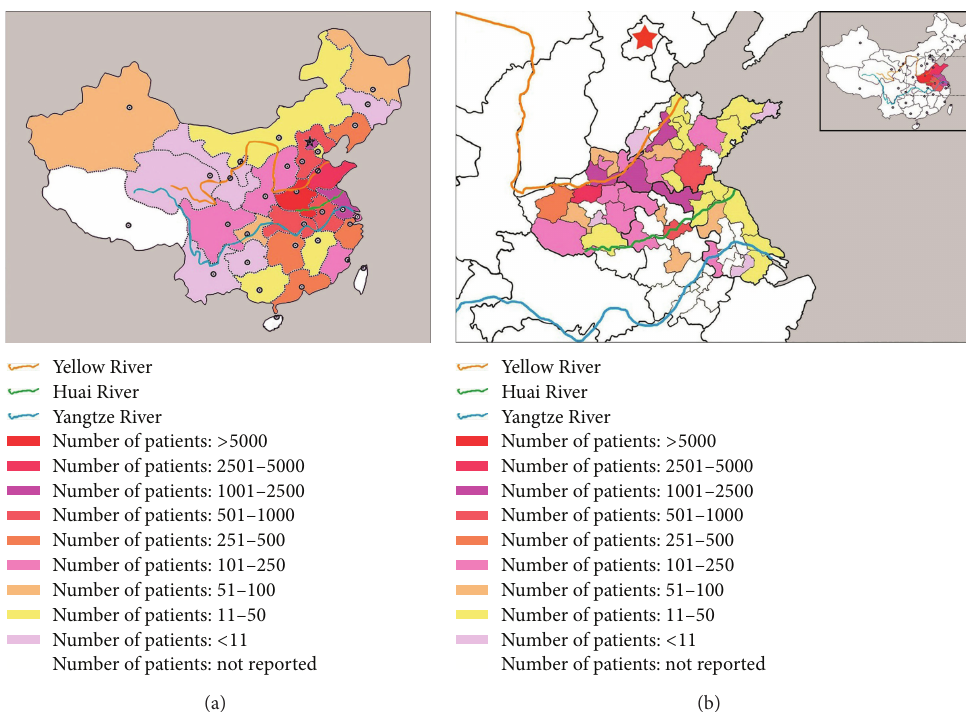
Figure 2: Distribution of BCS patients in China. (a) Distribution of BCS patients in 21 provinces, 4 autonomous regions, and 4 municipalities. (b) Distribution of BCS patients in the cities of Henan, Shandong, Jiangsu, and Anhui.